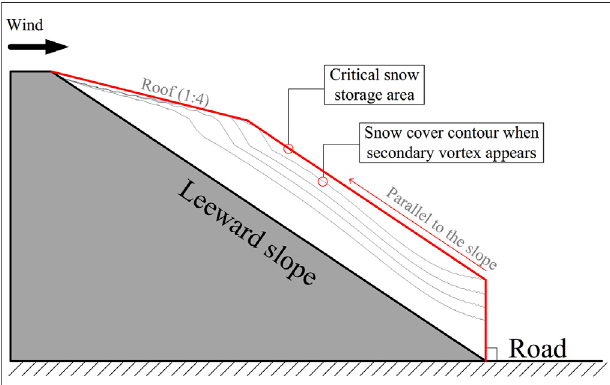
FIGURE 14 | Critical snow storage area. The trapezoid obtained by extending the cornice along the slope direction was de fi ned as the snow storagearea,whichisde fi nedasthesnowstoragearea.Furthermore,itcould be adopted as an index to measure the snow storage capacity of the cutting. The road surface can be cleared if the snow amount on the leeward side of the cutting is smaller than the critical amount of snow storage in the event of a snow disaster. And the road cutting does not enter the stage of rapid snow